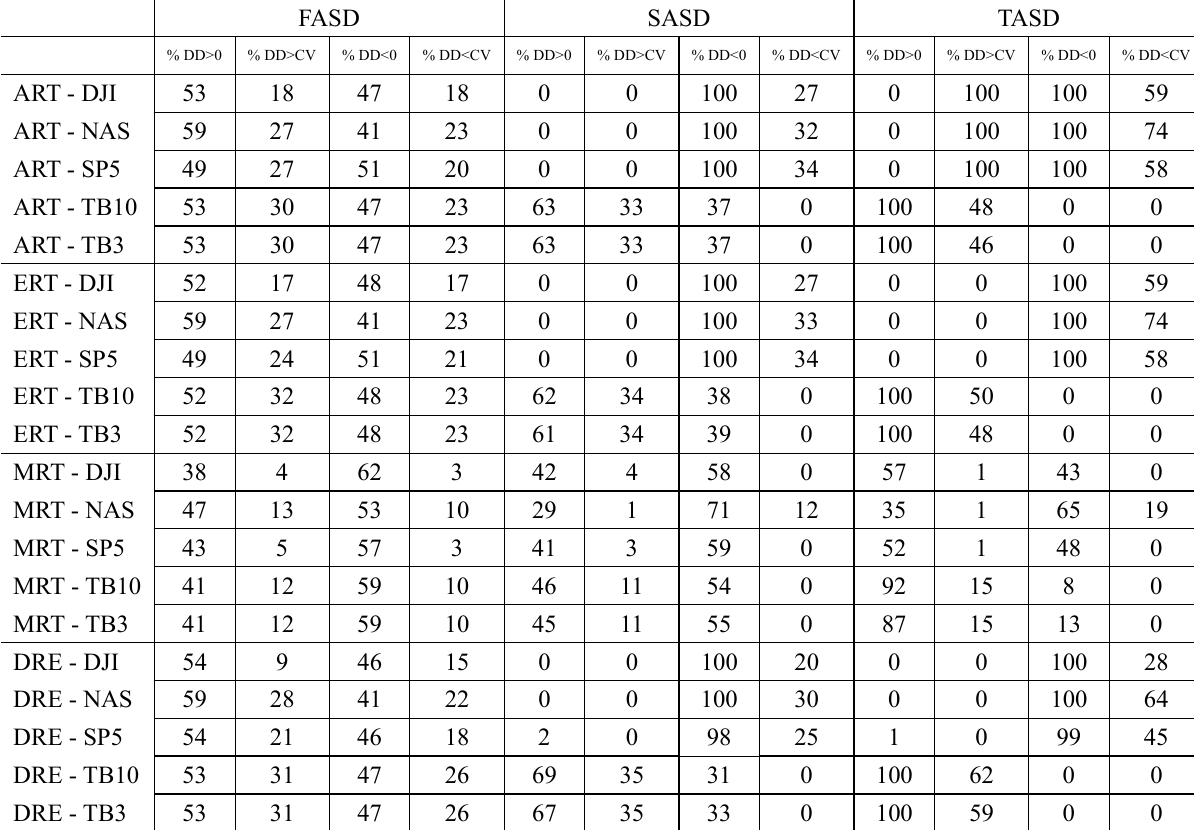
Table 2: Results of DD Test for Risk-Averters (1999–2005)